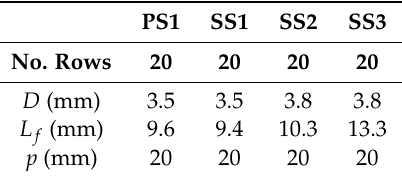
Table 2. Geometric details—film